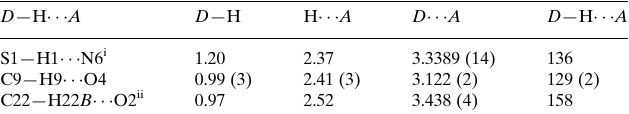
Hydrogen-bond geometry (A˚ , (cid:3)